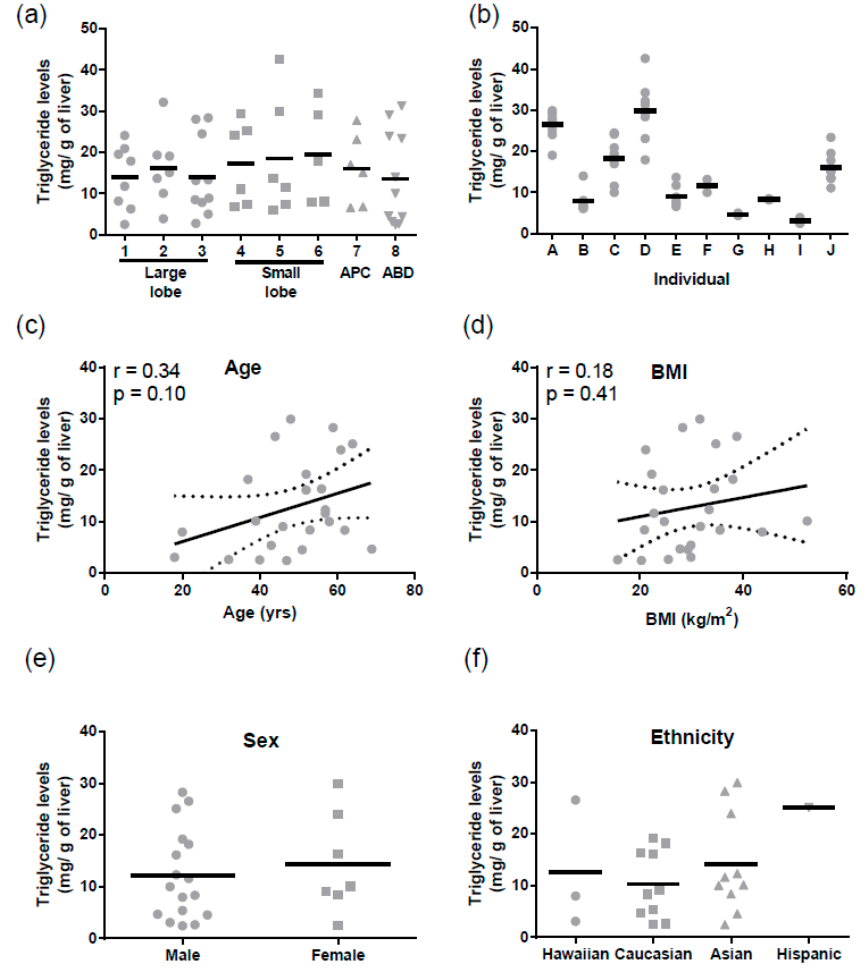
Figure 3: Triglyceride levels in human liver lysates. ( a ) The regional expression of hepatic triglyceride levels: 1 & 4 distal, 2 & 5 medial, 3 & 6 central, APC = adjacent to portal circulation and ABD = adjacent to bile duct, see Figure 1a for detailed liver regions; ( b ) The inter- and intra-individual expression of triglycerides levels. The correlation of triglyceride levels with ( c ) age and ( d ) BMI. The relationship between triglyceride levels and ( e ) sex and ( f ) ethnicity.